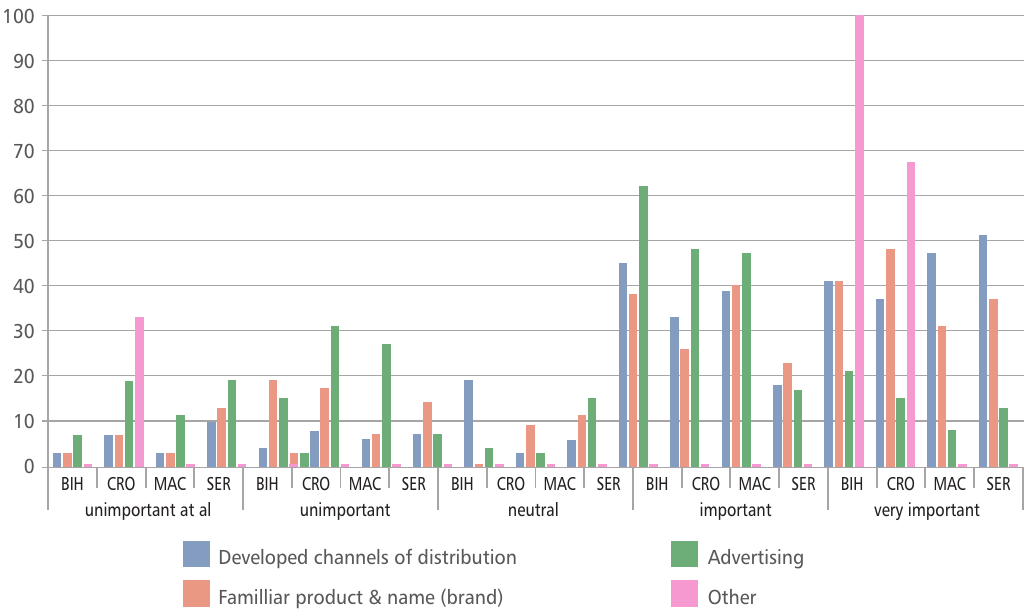
FIGURE 2. The importance of marketing tools in % by country (sample size: 30 companies in B&H; 71 companies in Croatia; 36 companies in Macedonia; 91 in